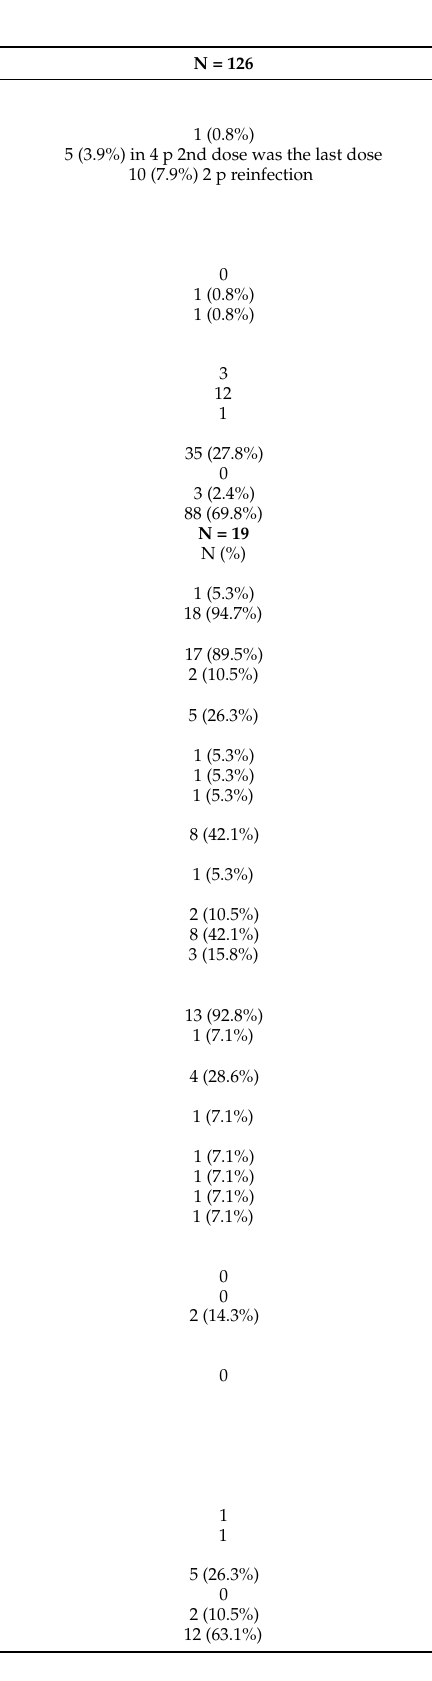
Other disease or COVID-19-unrelated deaths